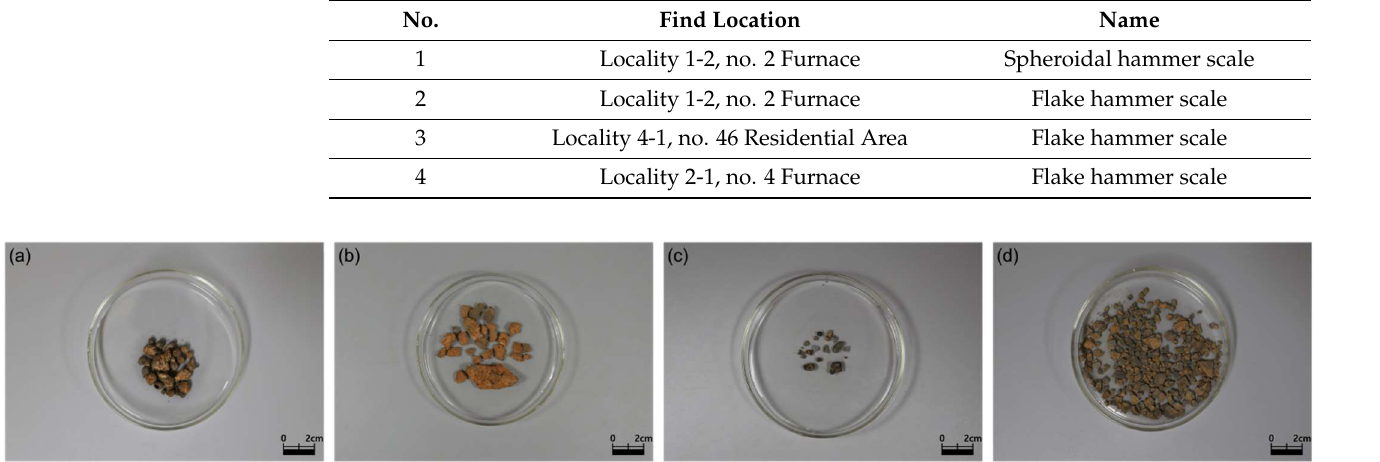
Figure 3. Flakes excavated from the Jincheon Songduri site: ( a ) spheroidal hammer scale, ( b ) flake hammer scale, ( c ) flake hammer scale, ( d ) flake hammer scale. Table 1. List of flake samples excavated from the Jincheon Songduri site.